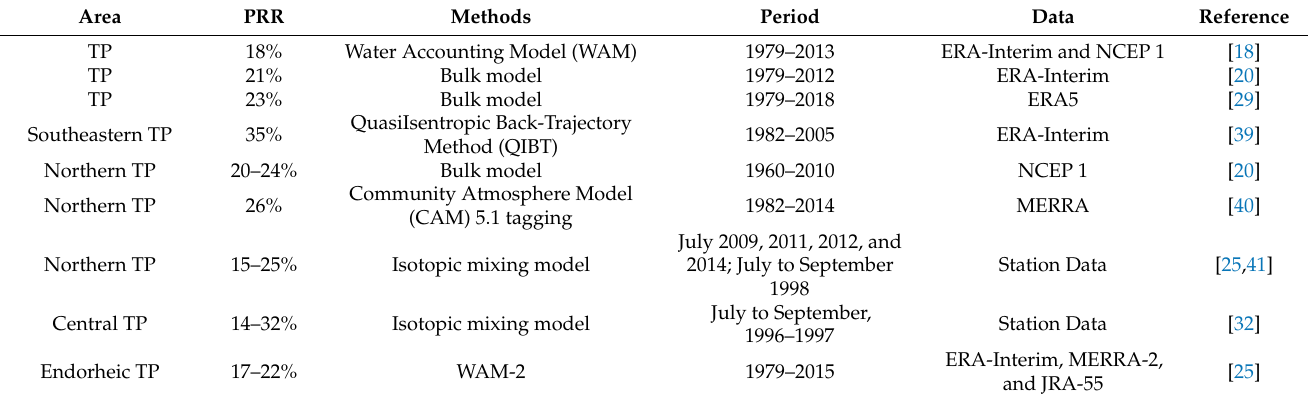
Table 1. Previous studies on the precipitation recycle ration (PRR) over the